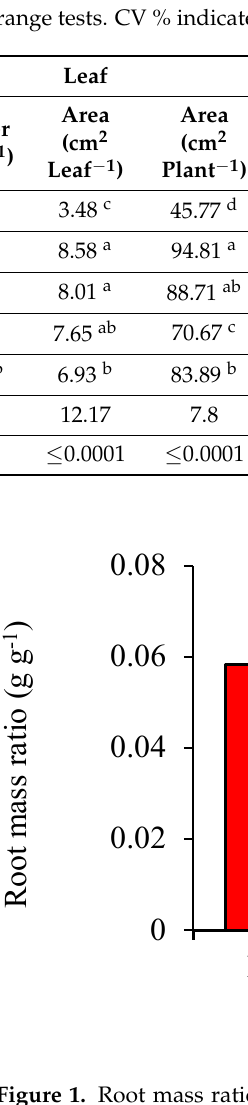
Table 1. Growth and morphology of chrysanthemum cuttings exposed for 30 days to different light quality regimes (red (R), red and blue (R:B), red, blue and far-red (R:B:FR), white (W) and blue (B); see the spectrum in Figure 9). During the experiment, the photosynthetic photon flux density was set to 150 ± 5 µmol m −2 s −1 . Six replicates per treatment were assessed. Means within a column fol- lowed by the same letters are not significantly different at p ≤ 0.05, according to Duncan's multi ple range tests. CV % indicates the percentages of coefficient of variation among the treatments. Spectrum